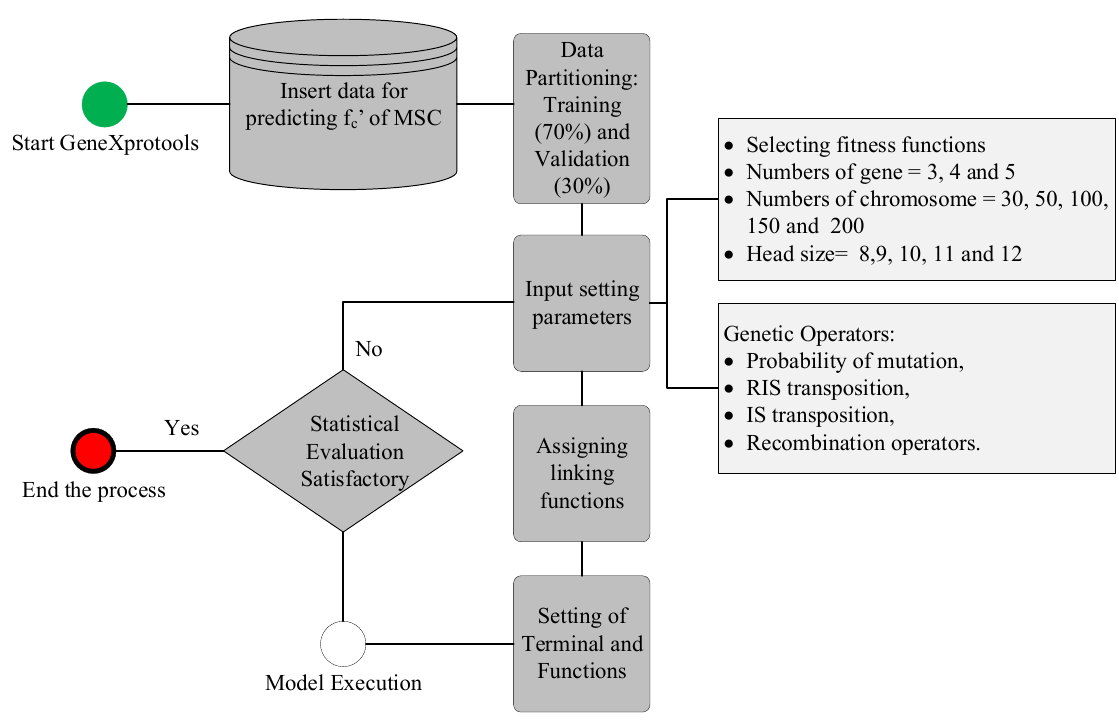
Figure 2. Flowchart of the study.